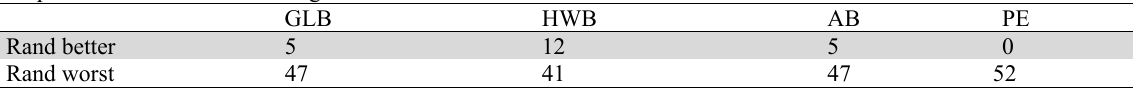
Comparison of the lower bounding methods with Rand – median